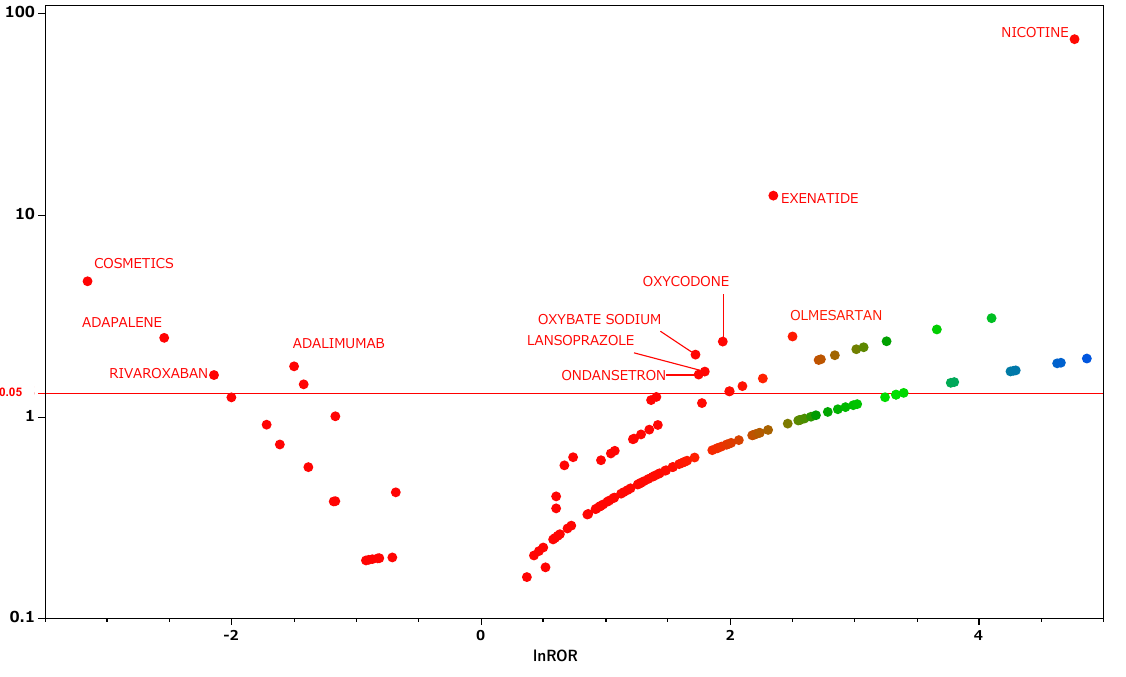
Figure 5. The same as Figure 3, except that this is a scatter plot for the female table. From these data, we extracted drugs with reporting odds ratios greater than unity, Fisher’s exact test p -values of less than 0.001, and more than 5000 reported adverse effects. We then performed multivariate analyses on those drugs with the patient information. The results are shown in Table 2. The results identified male gender, older age, and lower body weight as risk factors for hiccups in the patient information. Fifteen drugs were extracted as risk factors, including nicotine, fluorouracil, sunitinib, aripiprazole, exenatide, antithymocyte immunoglobulin, sertraline, capecitabine, gemcitabine, granisetron, dexa- methasone, bortezomib, sorafenib, cisplatin, and methylprednisolone. The ROC-AUC, which indicates the prediction accuracy of the model value, was 0.82.